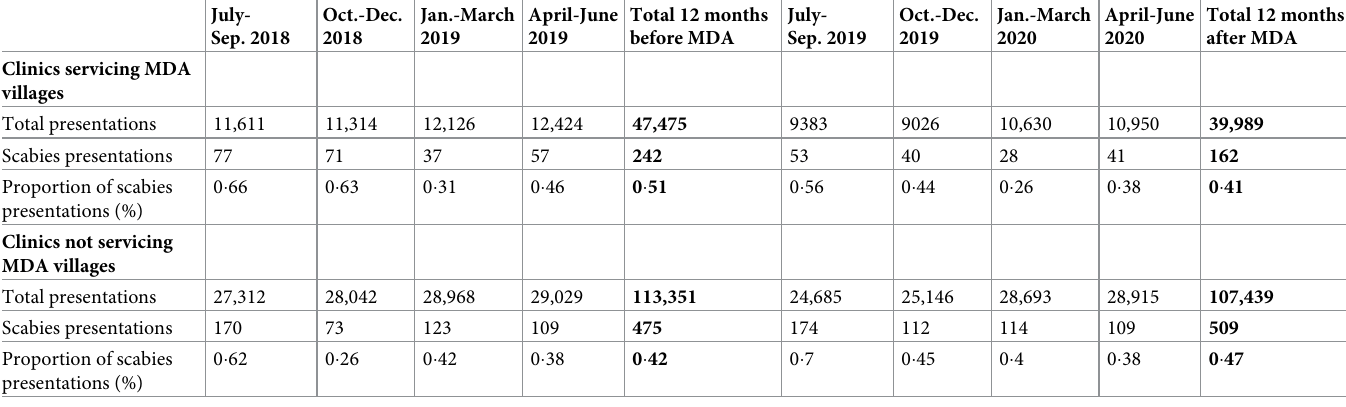
Table 3. Presentations to Western Province health clinics in the year before and after mass drug administration (total presentations, presentations diagnosed as scabies and proportion of scabies presentations compared to total